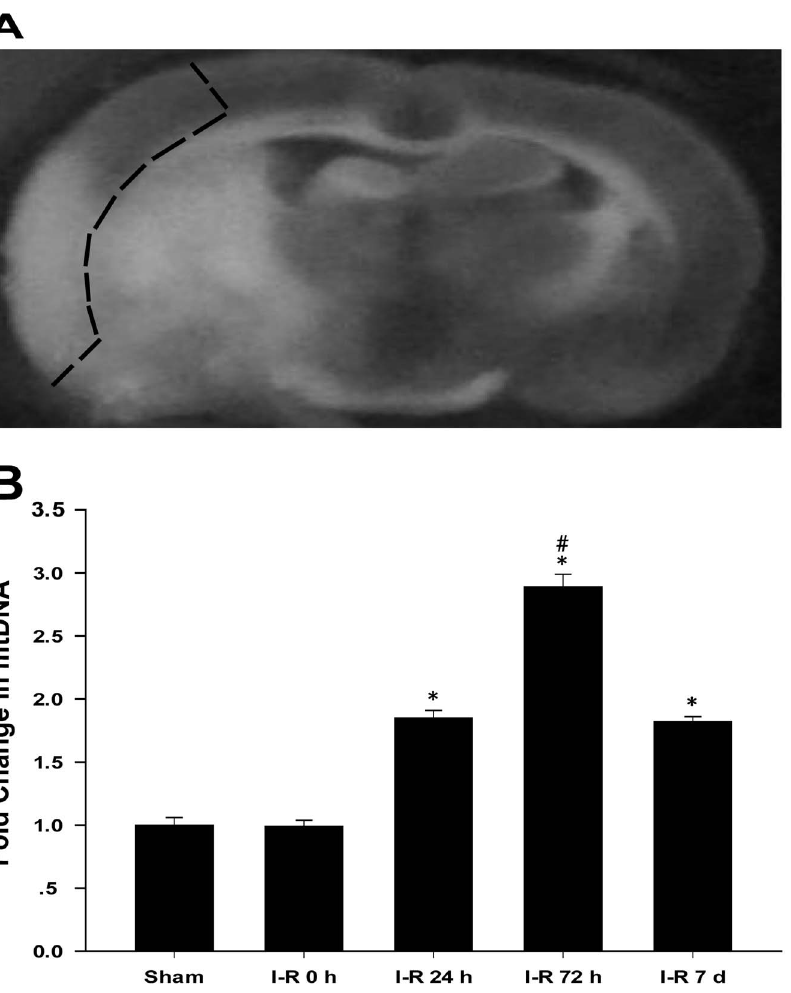
Figure 1. Change in the relative amounts of mtDNA after I-R. (A) Cortical tissue samples indicated by dotted line were used for PCR, Western Blot examination, citrate synthase activity assay, and morphology observation. (B) The relative amounts of cortical mtDNA were measured using quantitative real-time PCR in the sham group and the I-R 0 h, I-R 24 h, I-R 72 h, and I-R 7 d groups. The data are expressed as the means 6 SD. *P , 0.05 versus the I-R 0 h and sham groups; # P , 0.05 versus the I-R 24 h and I-R 7 d groups. doi:10.1371/journal.pone.0092443.g001 according to the manufacturer’s instructions. The primer pairs for rat peroxisome proliferator-activated receptor coactivator-1 a Table 2. The PCR reactions comprised 35 cycles for PGC-1 a , (PGC-1 a ), nuclear respiratory factor-1 (NRF-1), mitochondrial NRF-1, and TFAM and 30 cycles for b -actin. The PCR cycling transcription factor A (TFAM), and b -actin were derived from conditions for these genes were as follows: 30 s at 94 u C for EMBL/GenBank sequences using computer analysis software. denaturing, 30 s at 56 u C for annealing, and 30 s at 72 u C for